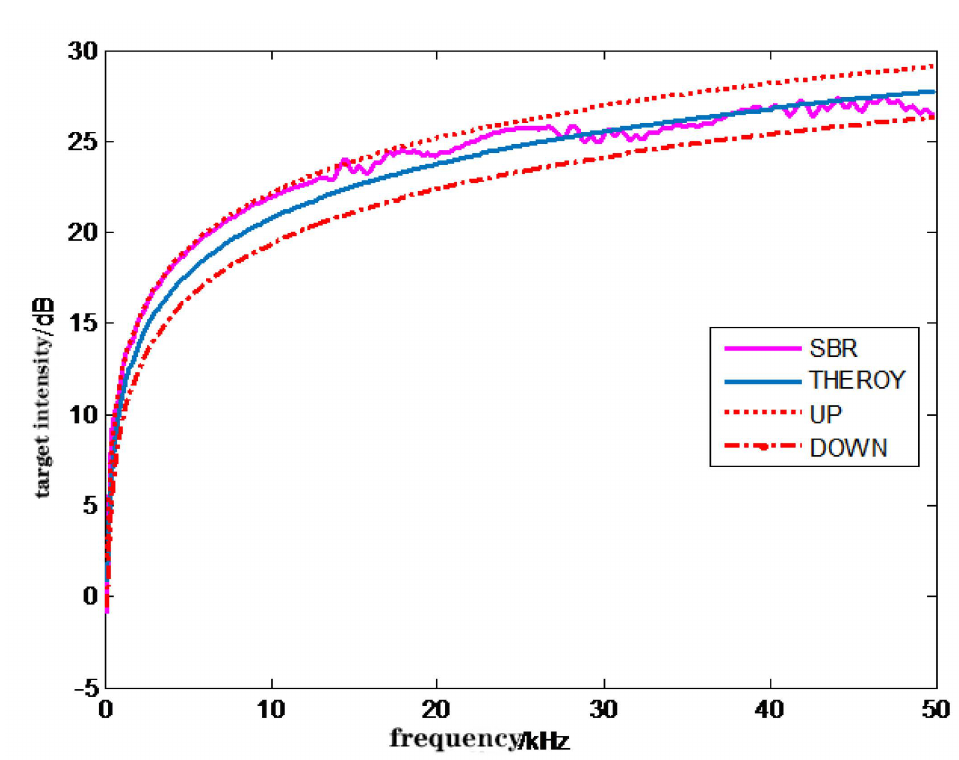
Figure 8. Cylindrical frequency–intensity